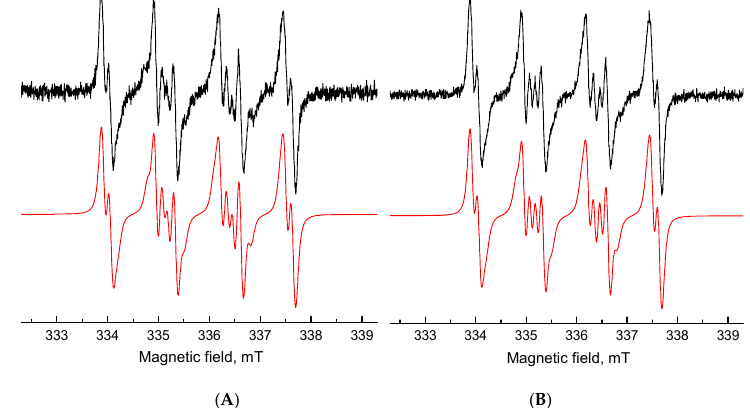
Figure 3. Experimental ( – ) and simulated ( – ) EPR spectra obtained after 13 min UVA exposure of the DMSO solution of ( A ) berberine and ( B ) berberine derivative 3 in the presence of DMPO spin trap under air. (Initial concentrations: c 0 (berberine) = c 0 (berberine derivative 3 ) = 0.001 M, c 0 (DMPO) = 0.042 M, λ max = 365 nm, irradiance 13 mW·cm − 2 ).